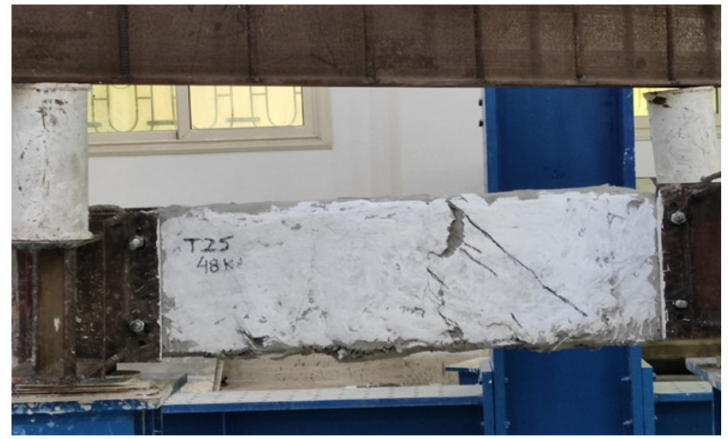
Figure 20. Final crack of beam